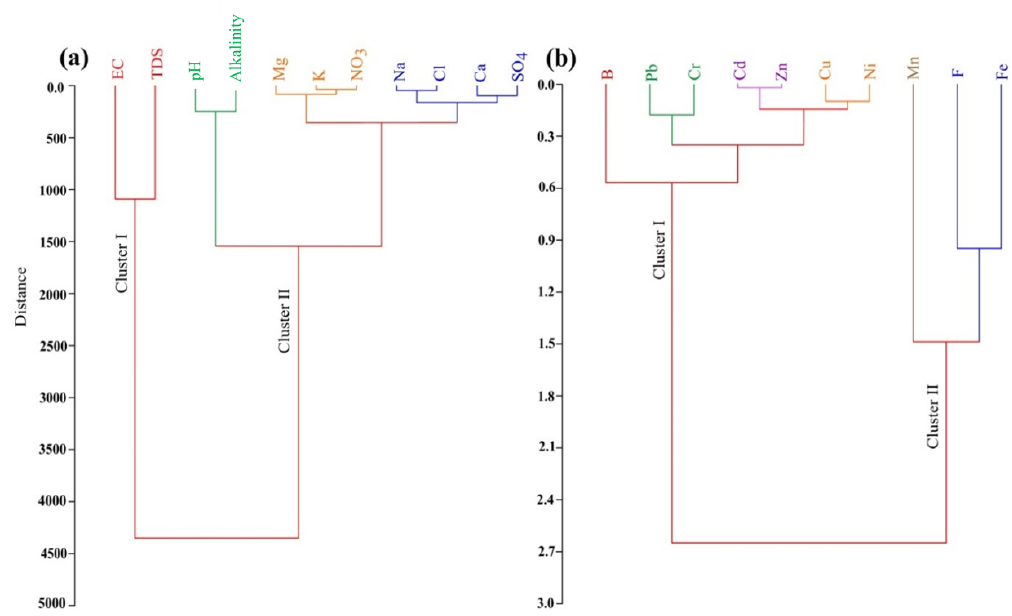
Figure 4. Cluster Analysis (CA) for surface water physicochemical parameters across two years: ( a ) CA for major ions and ( b ) CA for trace elements.